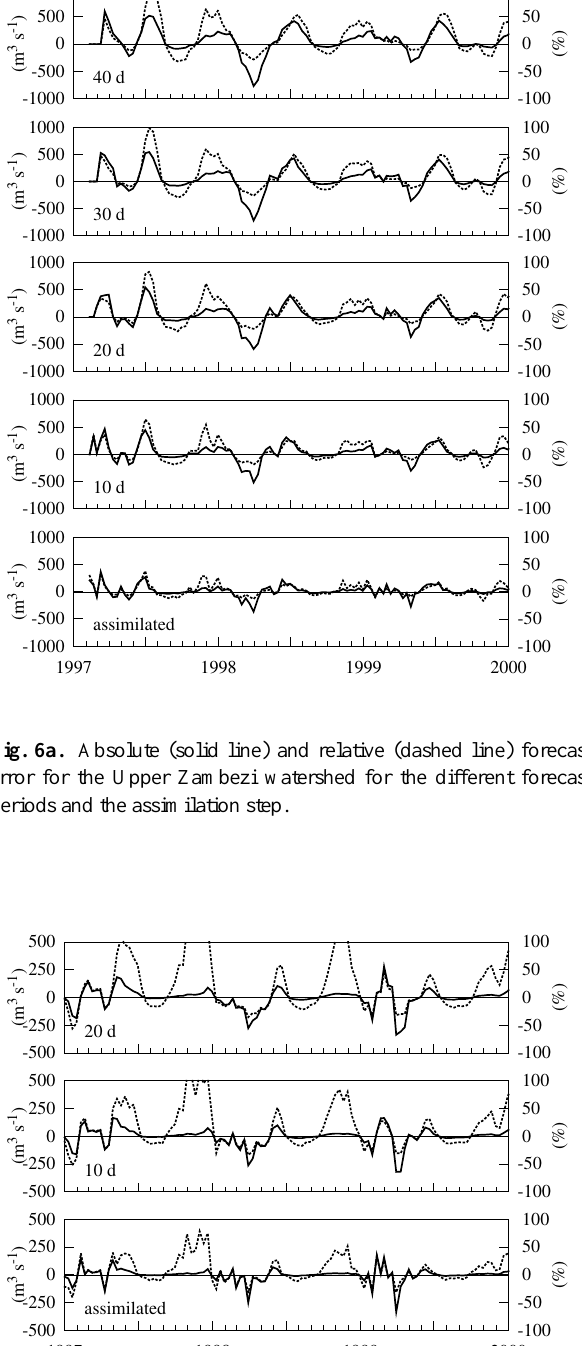
Table 2. RMSE of the different forecast lead times up to the max- imum possible lead time ( 1τ S ). For comparison the RMSE of the deterministic model run and the reference method are indicated. All values are given in m 3 s − 1 .